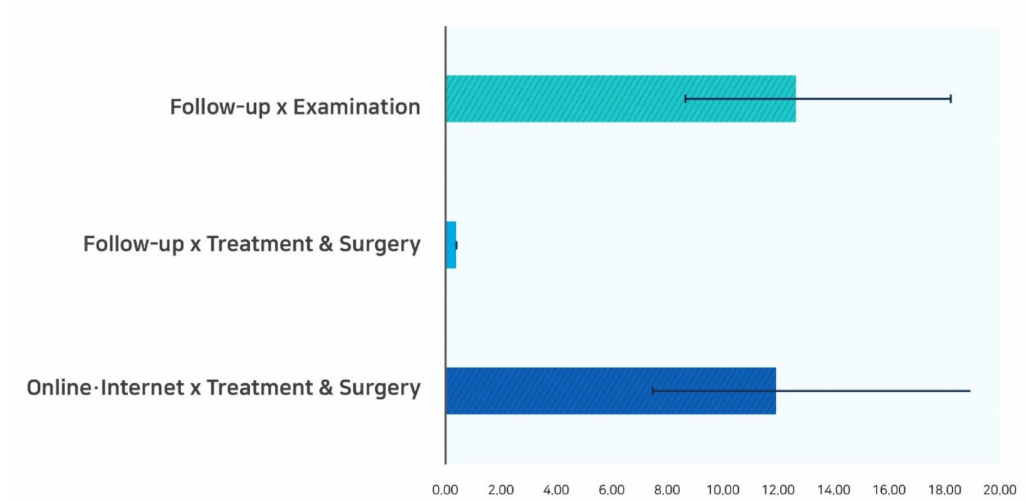
Figure 1. Multivariable logistic regression showing significant interaction between the modes of appointment-making and types of